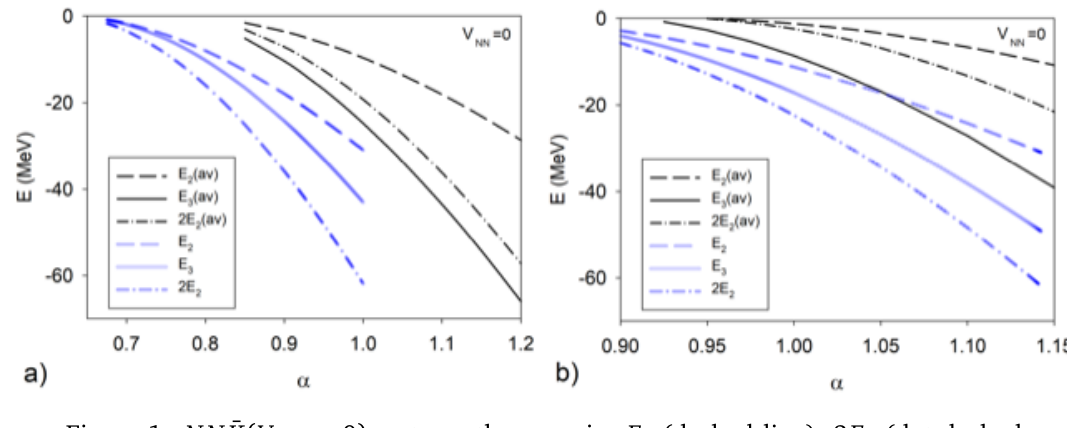
(dashed line), 2 E 2